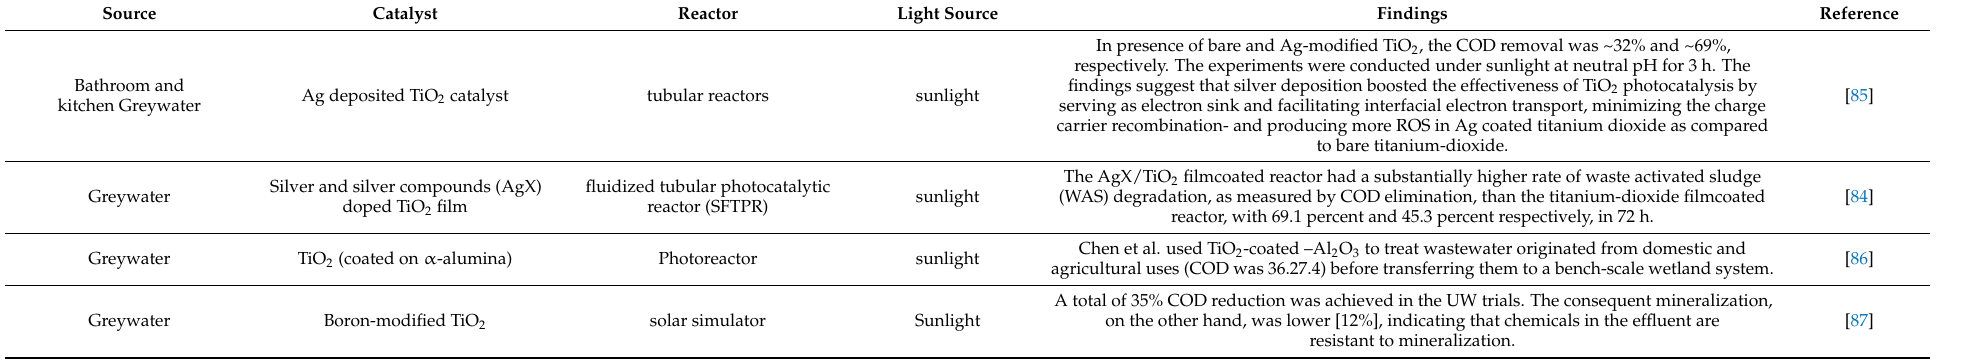
Table 6. Removal of COD from greywater by solar photocatalytic treatment using doped TiO 2